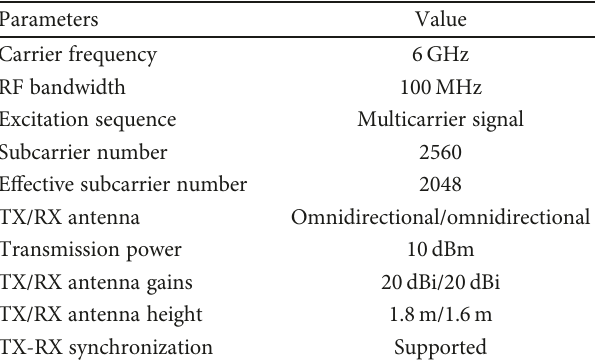
Table 1: Channel sounding system parameters used at